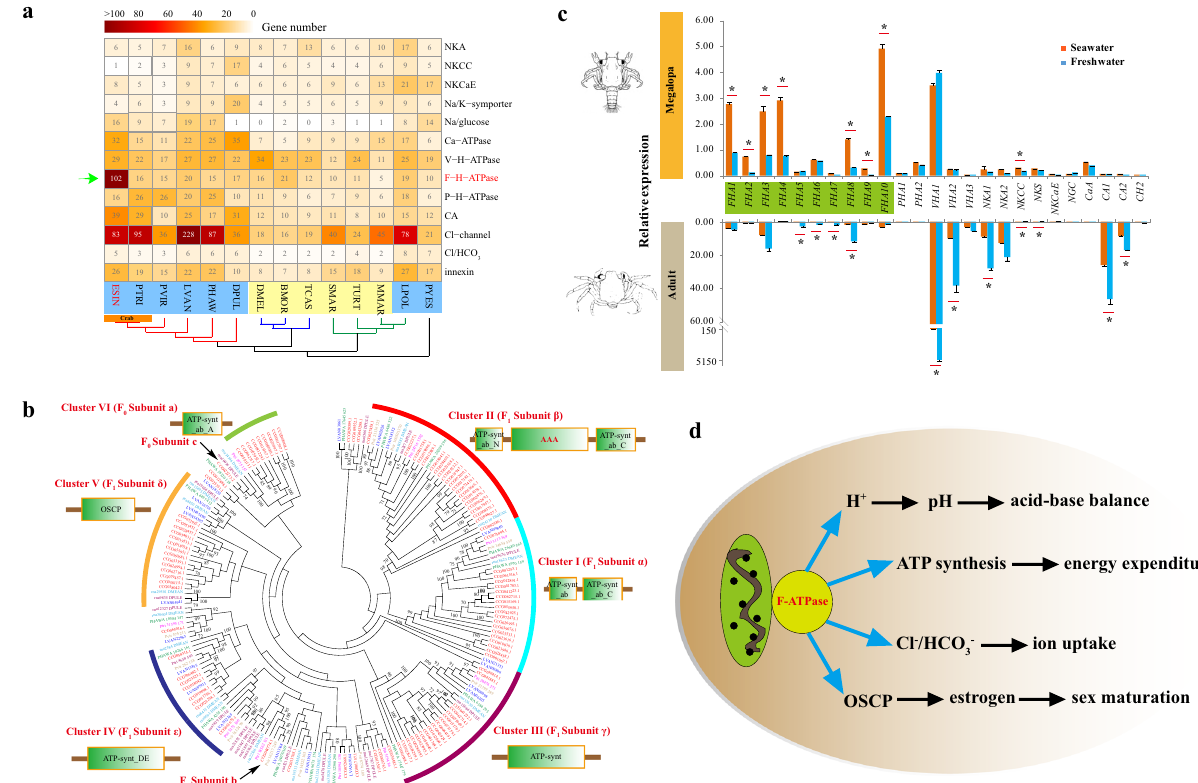
Fig. 3 Osmoregulation related genes in the E. sinensis genome. a Gene copy numbers of different osmoregulation related genes among arthropods 123,124 . F-H-ATPase is the only gene family that signi fi cantly expands in the E. sinensis genome. The species in the comparison includes E. sinensis (ESIN), Portunus trituberculatus (PTRI), Procambarus virginalis (PVIR), Parhyale hawaiensis (PHAW), Daphnia pulex (DPUL), Drosophila melanogaster (DMEL), Bombyx mori (BMOR), Tribolium castaneum (TCAS), Strigamia maritima (SMAR), Mesobuthus martensii (MMAR), Tetranychus urticae (TURT), Limulus polyphemus (LPOL), and Patinopecten yessoensis (PYES). The osmoregulation related genes include Na + /K + ATPase (NKA), Na + /K + /2Cl - cotransporter (NKCC), Na + /K + /Ca 2 + exchanger (NKCaE), Na + /K + symporter (Na/K-sympoter), sodium/glucose cotransporter (Na/glucose), Ca 2 + transporting ATPase (Ca-ATPase), Vacuolar H + -ATPase (V-H-ATPase), F-type H + -transporting ATPase (F-H-ATPase), P-type H + -transporting ATPase (P-H-ATPase), Carbonic anhydrase (CA), chloride channel protein (Cl-channel), Na + -independent Cl/HCO 3 exchanger (Cl/HCO 3 -exchanger), and innexin. b Expansion of F-ATPase in the E. sinensis genome. F-ATPase consists of two domains: F 0 domain (containing three subunits: a – c ) that integrates in the membrane to promote passive H + transport, and F 1 domain (containing fi ve subunits: α , β , δ , γ , ε ) which is easily released from the membrane, catalyzing hydrolysis of ATP 44 . The expanded genes in each cluster share similar gene structures. The domains of each cluster were predicted by SMART. Genes from different species are represented by different colors: E. sinensis (red), P. hawaiensis (green), Daphnia pulex (orange), Drosophila melanogaster (blue). c The expression of osmoregulation related genes in megalopae (upper) and adults (lower) based on qPCR. Asterisks indicate the signi fi cant differences in gene expression between crabs in seawater (orange) and freshwater (blue). FHA F-H-ATPase, PHA P-H-ATPase, VHA V-H-ATPase, NKS Na/K-sympoter, CH Cl/HCO 3 - exchanger. d Potential functions of F-ATPase in osmoregulation and development of E. sinensis . F-ATPase performs its function through regulating acid- base balance, energy expenditure, ion uptake, and estrogen-targeting in sex